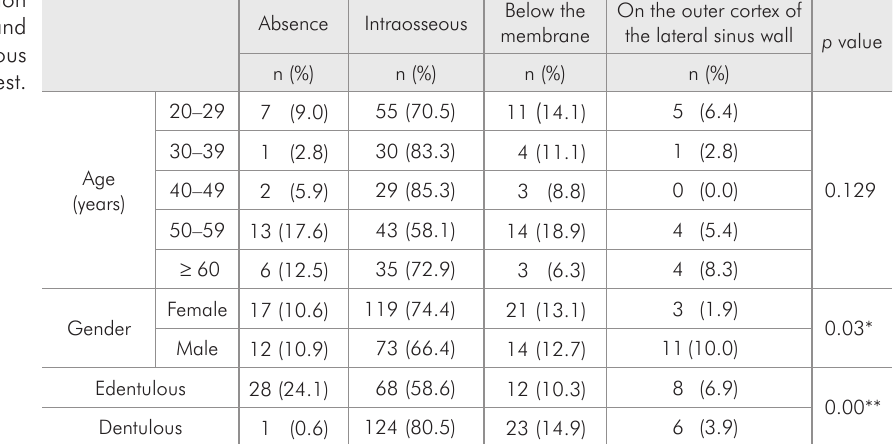
Table 1 - Artery localization according to age, gender, and